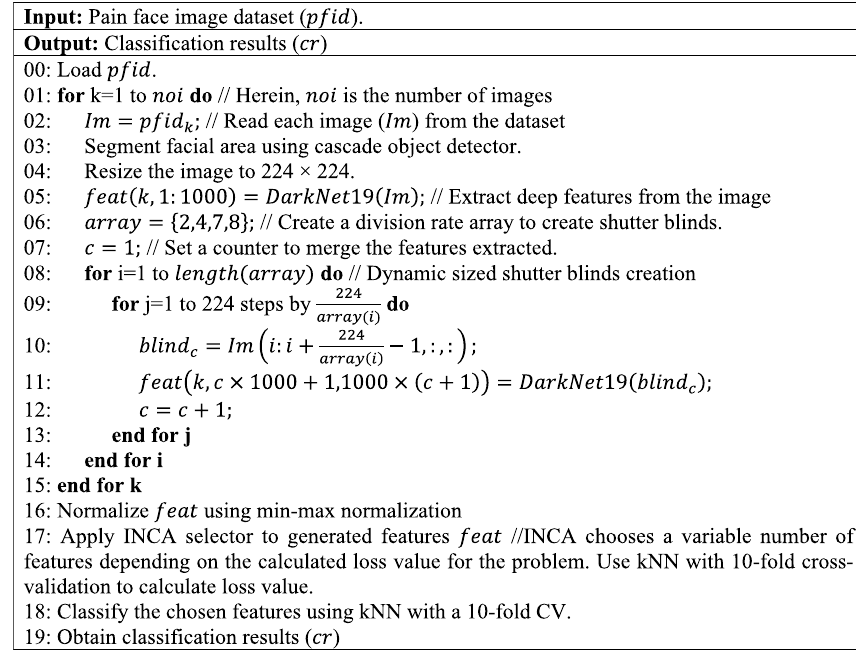
Algorithm 1 . Pseudocode of proposed shutter blinds-based model for classification of pain levels.